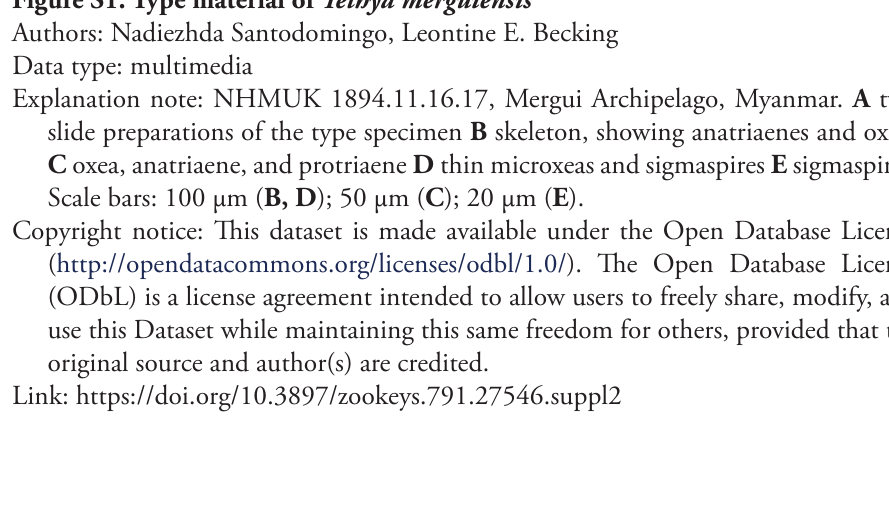
Figure S1. Type material of Tethya